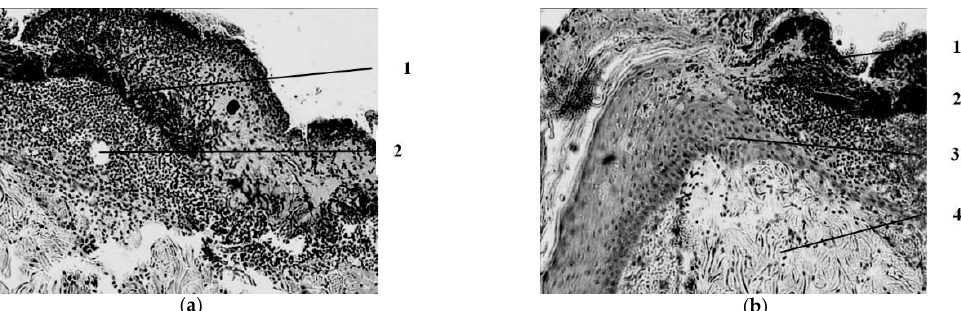
the wound with ozonated oil. Stained with hematoxylin and eosin. magn. × 50. ( a ) The scab is infiltrated by leukocytes and slightly separated from the wound surface. Purulent exudate